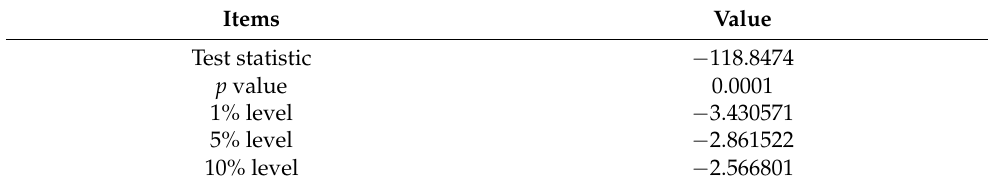
Table 2. Results of unit root